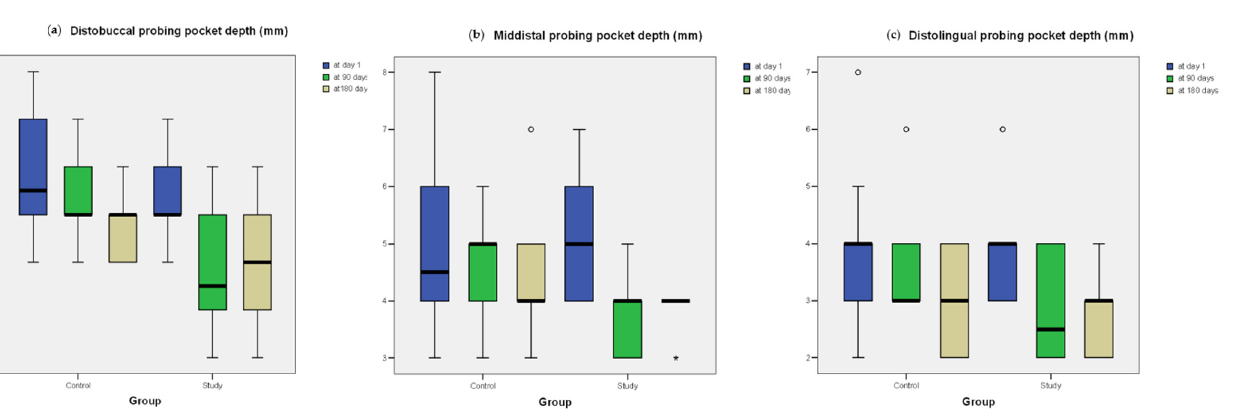
Figure 6. Graph of cumulative (distobuccal, middistal, distolingual) probing pocket depth (PPD, mm) of the distal aspect of the experimental site and the control site at different follow-up intervals. The comparison of the probing pocket depth mean values (mean PPD) of M2 ′ s distal aspect (distolingual, middistal, distobuccal) at times T1, T90 and T180 showed a positive trend in all parameters, recorded both at the experimental and the control sites (Table 1). A decrease of the PPD values was observed at both experimental and control sites, but with a greater reduction at the grafted sites. PPDs at the experimental sites decreased from an average of 4.53 ± 1.13 mm at T1 to an average of 3.16 ± 0.98 mm at T180, with a mean difference of 1.37 mm, while the PPDs at the control sites decreased from an average of 4.6 ± 1.67 mm at T1 to an average of 3.76 ± 1.04 at T180, with a mean difference of 0.84 mm. Specifically, the differences in terms of PPD at T1 and T180 were not significant on the distobuccal ( p = 0.368 and 0.065, respectively), middistal ( p = 0.944 and 0.096, respectively) and distolingual sites ( p = 1.000 and 0.414, respectively). However, the differences were statistically significant at T90 on each of the three sites (distobuccal: p = 0.014; middistal: p = 0.014; distolingual: p = 0.033).